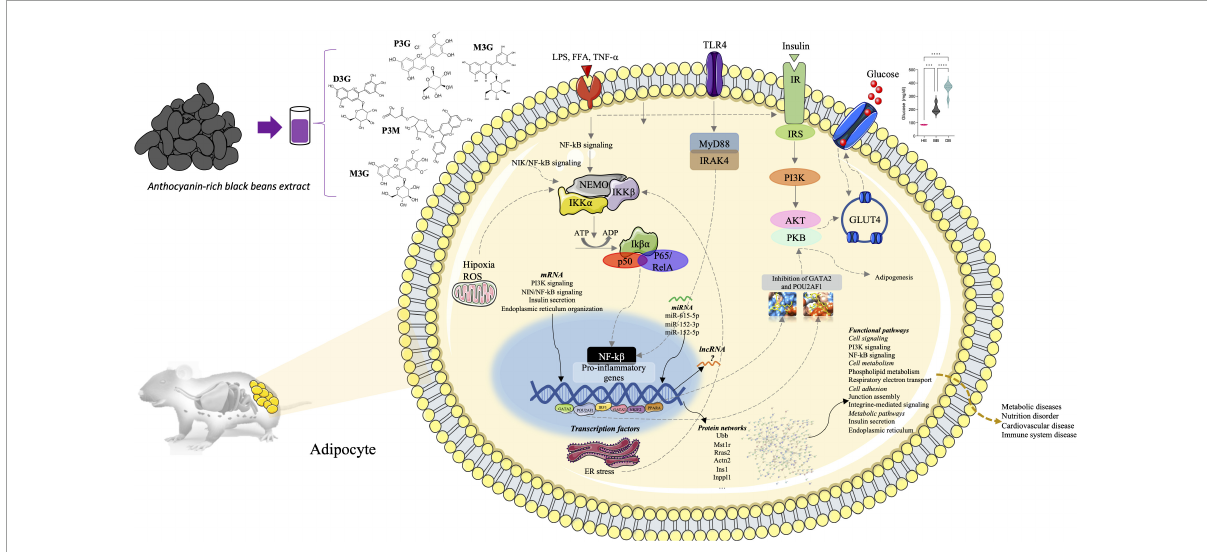
FIGURE8 Summary figure representing multi-omic results and genomic modifications induced in diabetic rats by anthocyanin-rich black beans extract supplementation.